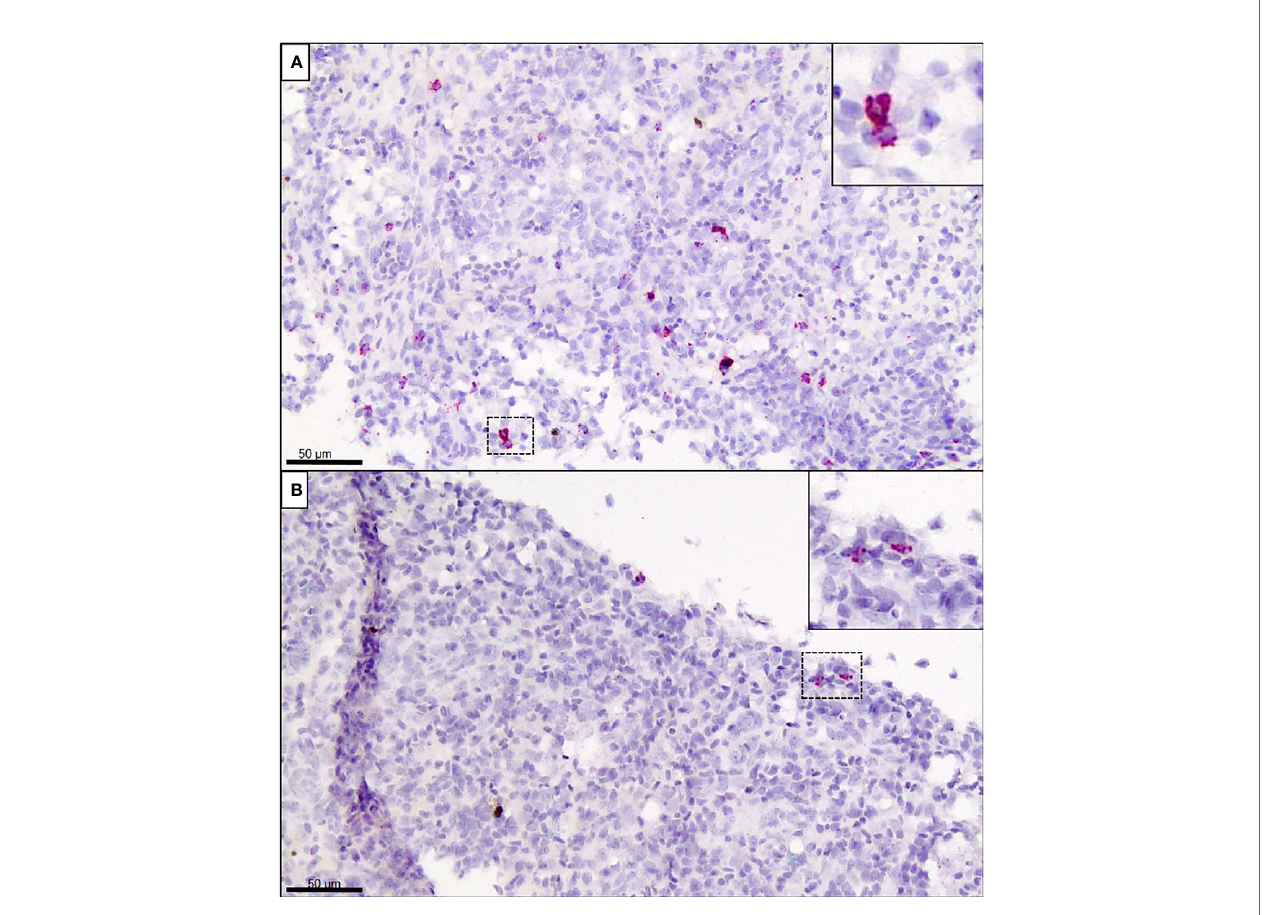
FIGURE 7 | In situ hybridization (RNAscope) targeting GzmA (stained in red) in spleen from Atlantic salmon at 14 dpe. (A) SGPV-exposed hydrocortisone-injected (E.H) group. (B) SGPV-exposed sham-injected (E.S)